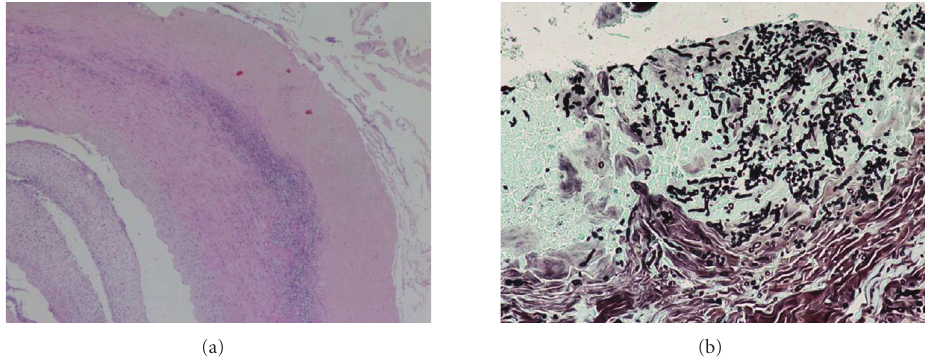
Figure 1: (a) 10x, Hematoxylin and eosin. Arterial wall with necrosis and inflammatory infiltrates; (b) 20x, Grocott. Fungal iphae in the arterial wall.